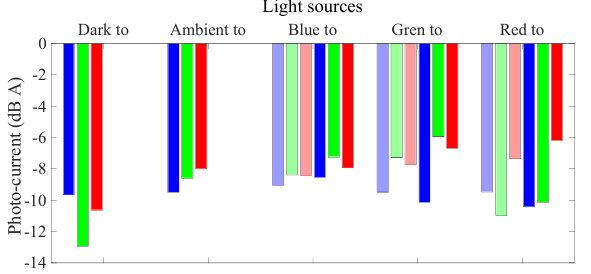
Figure 16. Photo-current measured on receiving monochromatic LED (blue, green and red) when illuminated by a light source biased with a forward current of 5 mA (lighter bars) and when illuminated by a light source biased at 20 mA (full color